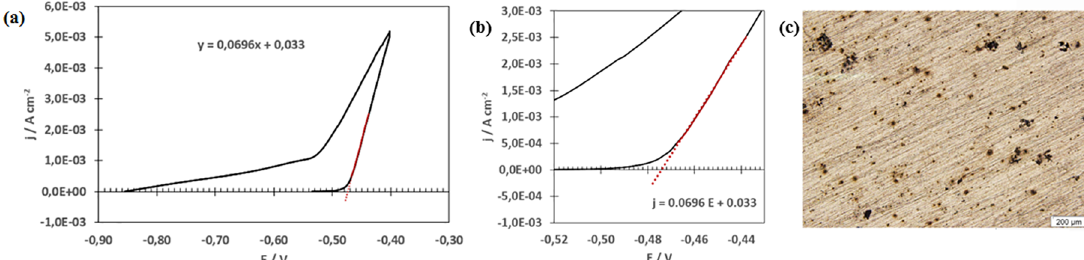
Figure 3. (a) Cyclic potentiodynamic polarization curve of the AA2524-T3 aluminium alloy in aerated 0.05 mol L -1 NaCl aqueous solution, (b) the magnified area for determining the pit nucleation potential (E =-0.474 V) and (c) image of AA2524-T3 aluminium alloy by optical pit microscopy of surface after the cyclic potentiodynamic polarization